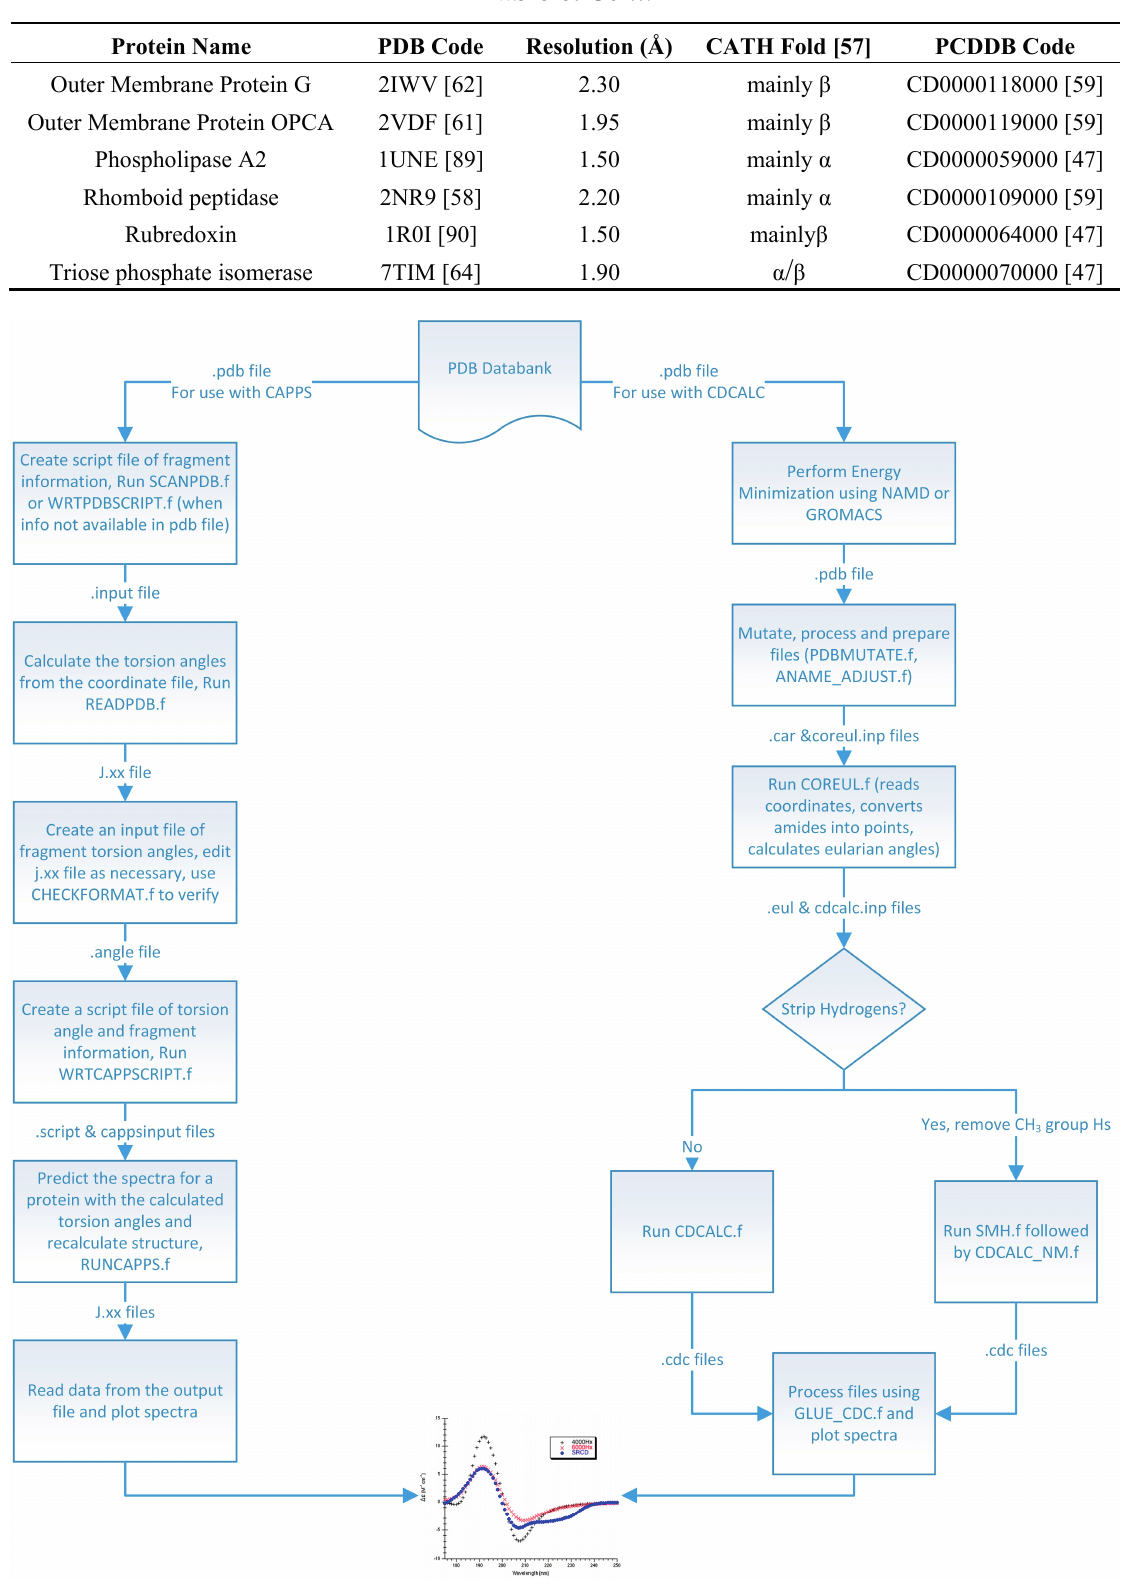
Figure 8. Flow Diagram of the DInaMo Package. Note, the CD spectrum, like the one pictured at the bottom of this diagram, can only be displayed using a common graphing program such as Origin or